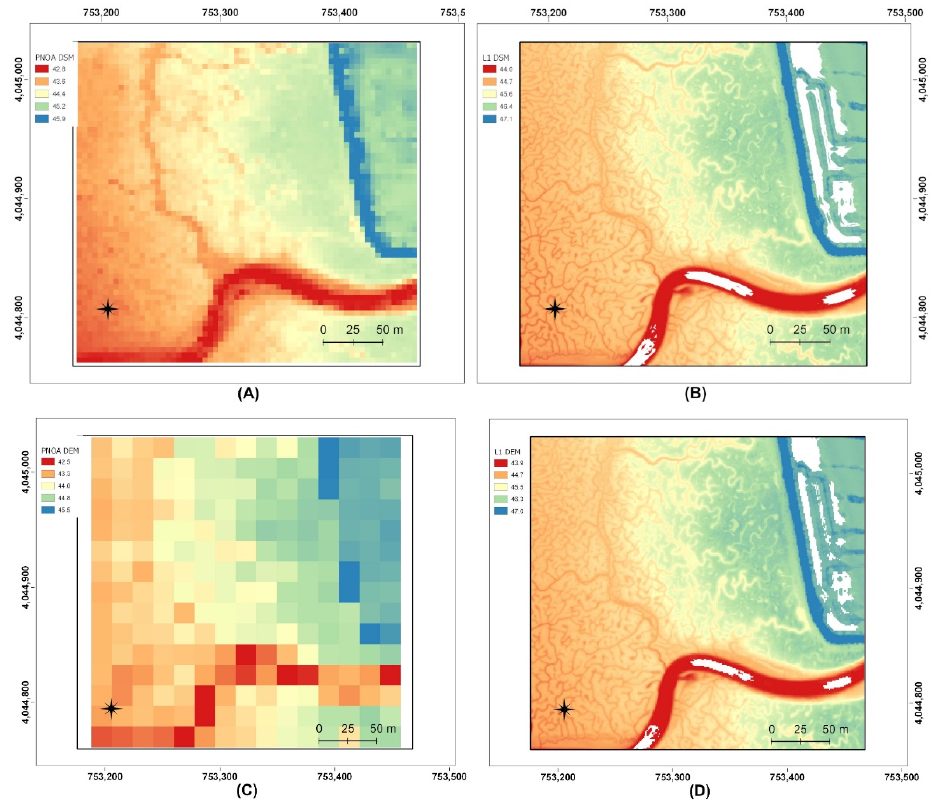
Figure 8. Comparison of PNOA 2015 and UAV-L1 products. ( A ) PNOA 2015 DSM. ( B ) 100 m-L1 DSM. ( C ) PNOA 2015 DEM. ( D ) 100 m-L1 DEM. Notice the great difference in resolution between PNOA 2015 and UAV-L1 products.